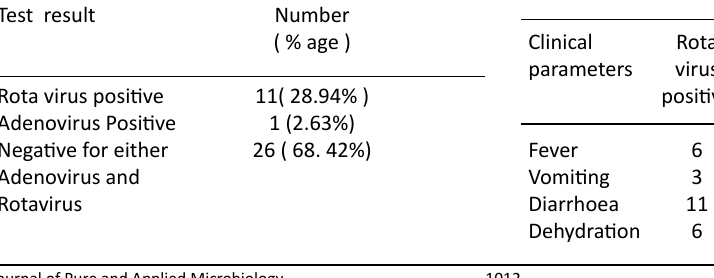
table 2. The clinical parameters of children with